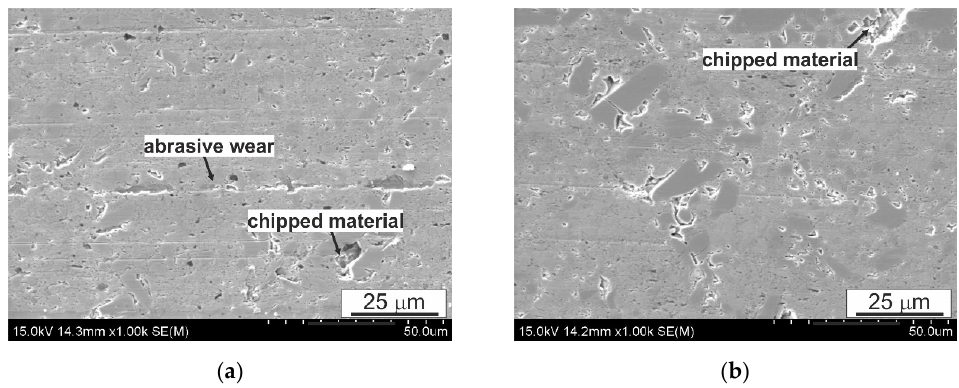
Figure 13. Characteristic sample surface of B89 alloy (FSP 280 RPM) after tribological tests in lubricated friction, ( a ) 10,000 m, ( b ) start-stop 10 × 1000 m; SEM.